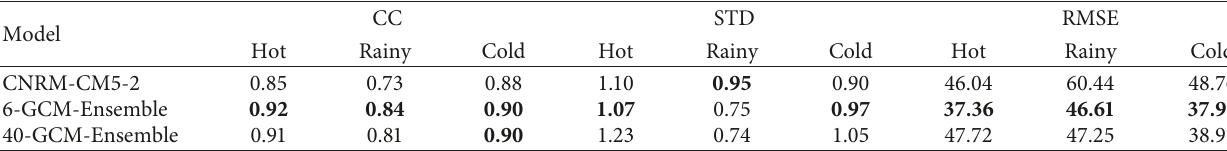
Bold face represents the best value for each performance